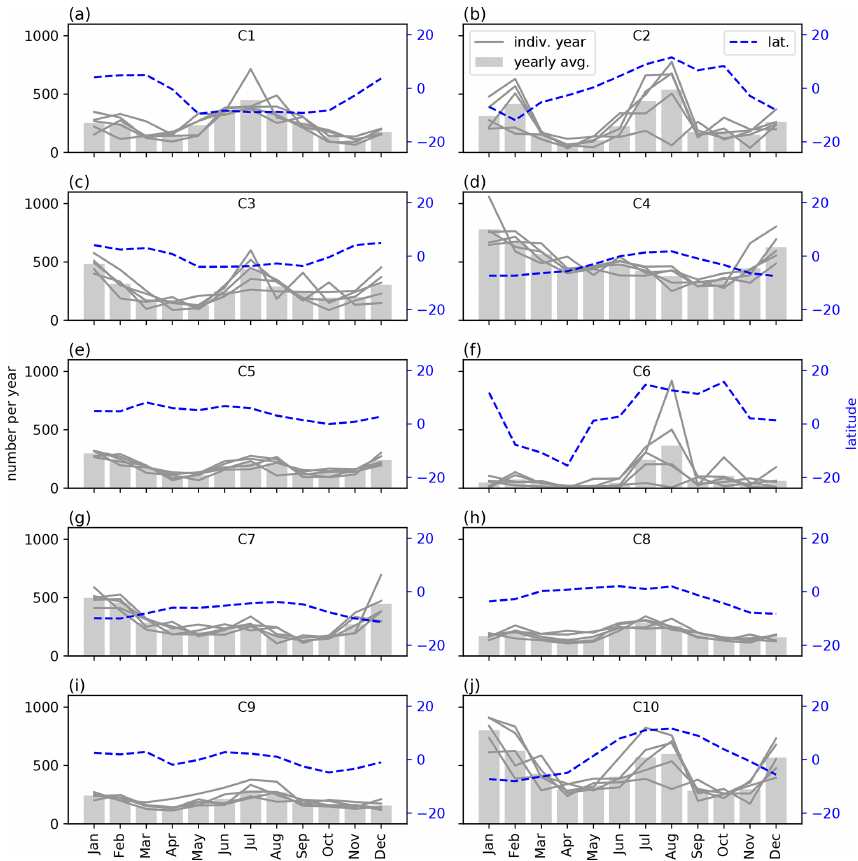
Figure 6. Seasonal variation in the 10 RWPs, showing the yearly average, each year individually and the mean latitude of occurrence.